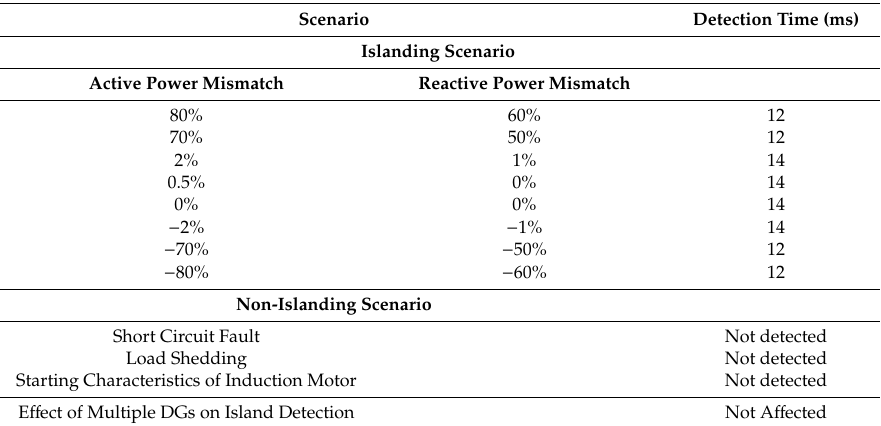
Table 5. Results of proposed